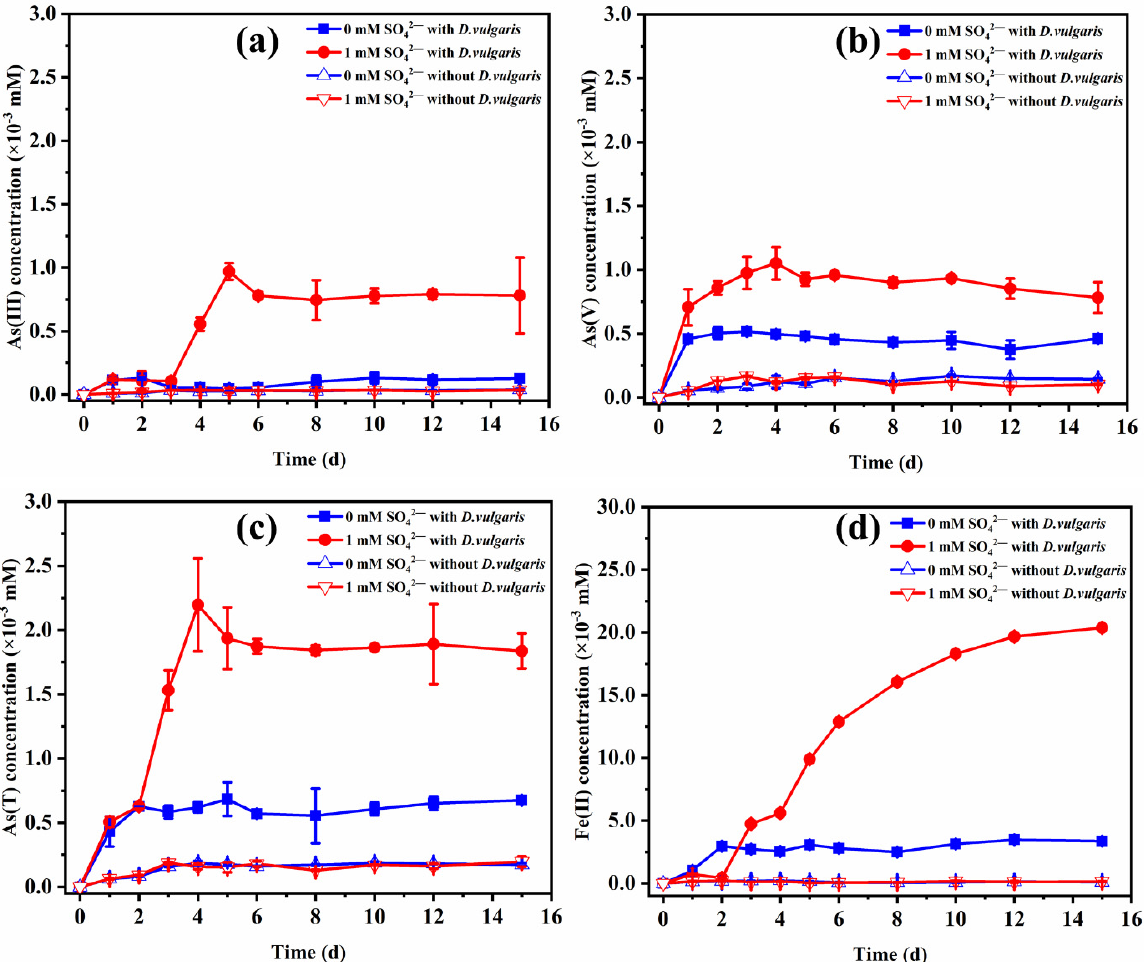
Figure 9. The changes of As(III) ( a ), As(V) ( b ), As(T) ( c ), and Fe(II) ( d ) concentrations during sediment experiment. Error bars indicate standard deviation of triplicates.